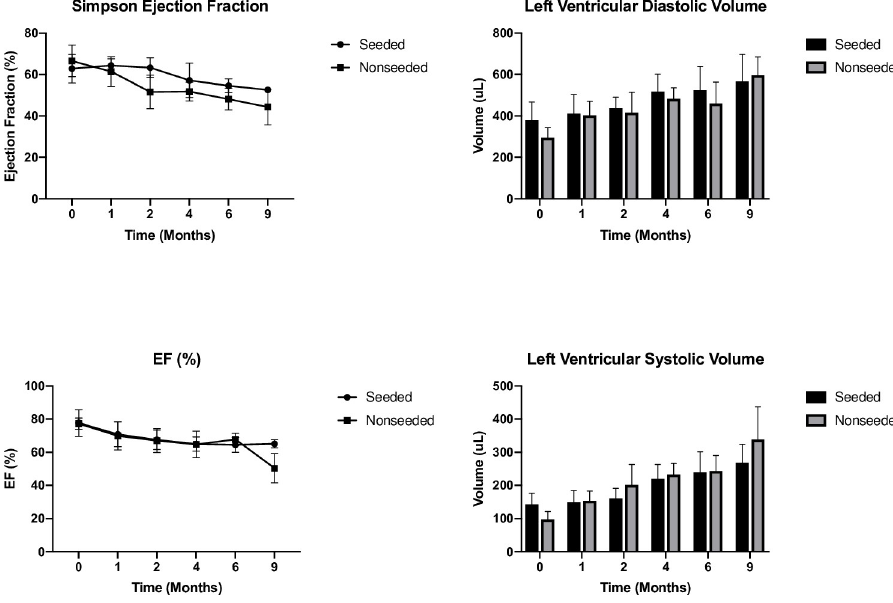
Fig 4. Echographic analyses over a period of 36 weeks compared to baseline: LV Ejection fraction (EF); LV diastolic volume; LV systolic volume. There are no aneurysmal changes in either